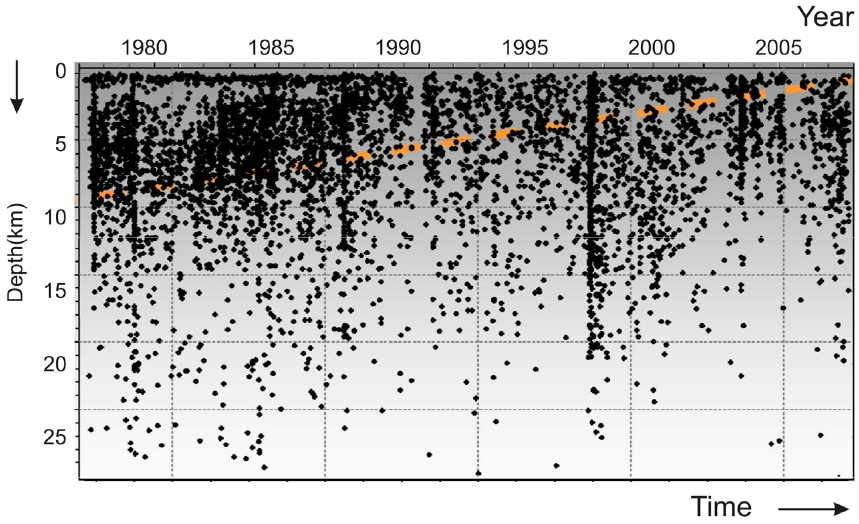
Figure 12. Time evolution of the hypocentral depths according to the Hypo3D algorithm. Orange dashed line shows a dipping, increasing